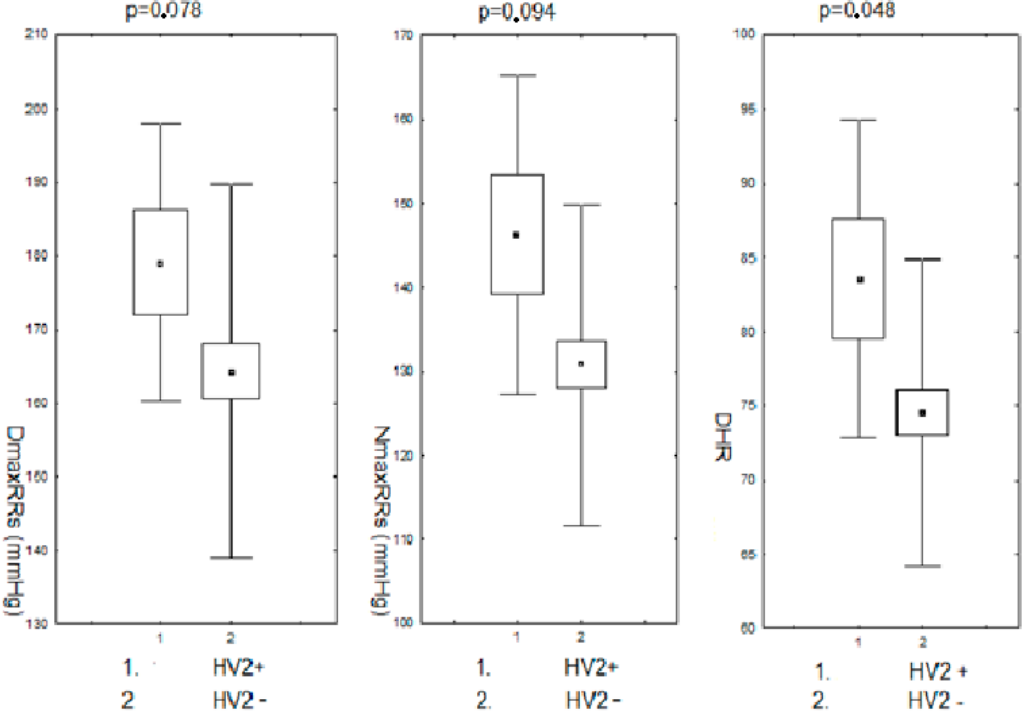
Figure 4. Maximum systolic blood pressure during the day and night and heart rate/min during the day in pre- and postmenopausal women with hypertension with changes in the HV2 regions. DDmaxRRs-daily maximum systolic blood pressure; NmaxRRs-nighttime maximum systolic blood pressure; DHR-daily heart rate; HV2+,-positive for HV2 changes; HV2 − ,-negative for HV2 changes. 3.8. Nucleotide Coding Sequence Changes in 12S RNA and RR Monitoring Changes in the nucleotide sequence in the 12S RNA coding region were associated with the modification of the parameters of the monitored RR in their presence, but only in a way close to statistical significance. Maximum daytime and nighttime systolic RR and daytime heart rate were slightly higher in the group of subjects with nucleotide sequence changes in the coding region of the 12S RNA compared to the corresponding values in the group without these changes. The differences in each case were close to statistical signifi- cance. The other parameters of the monitored pressure showed no differences between these groups. These data are presented in Figure 5.